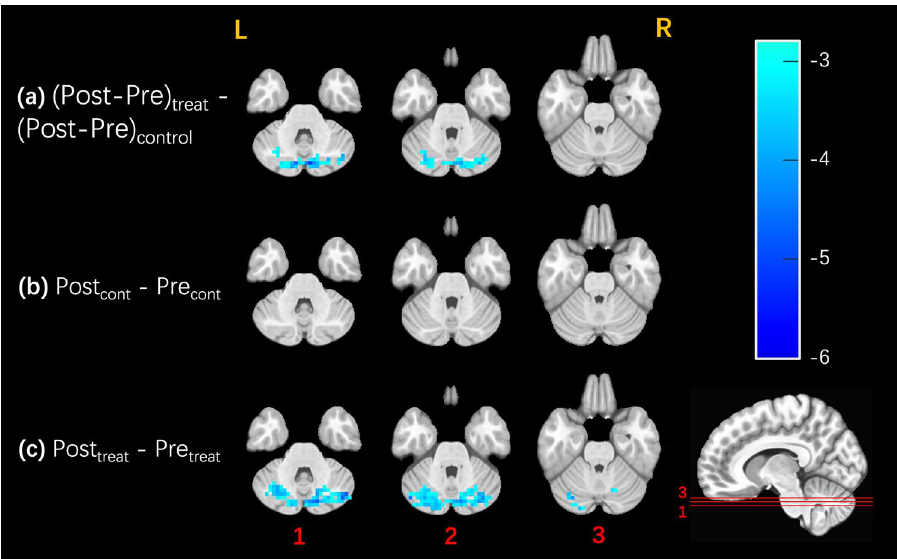
Figure 2. Maps showing clusters of voxels with significant effects, FWE-corrected at p < 0.05 with voxelwise threshold p < 0.01. Contrast-dependent cluster size thresholds based on permutation testing are indicated below. Surviving voxels are color-coded by their t-statistic value and overlaid on anatomical images, with the same slices shown for all three contrasts. No significant clusters were observed in any of the other slices. (a)